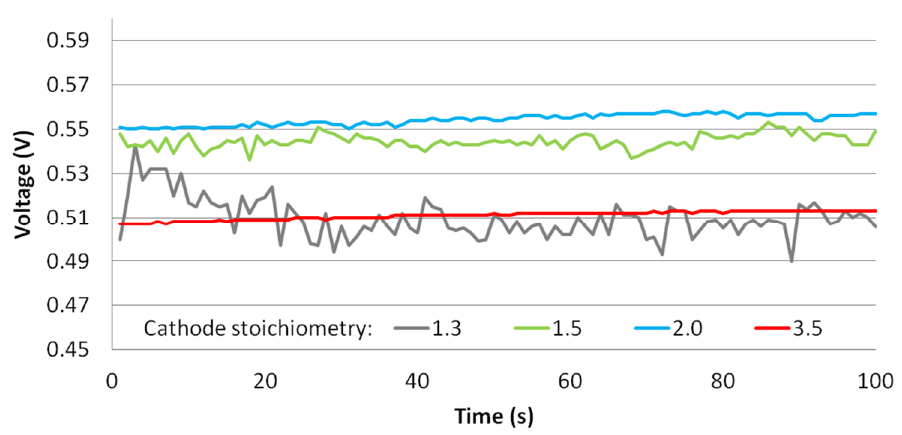
Figure 10. Time evolution of the cell voltage for the cathode stoichiometry tests at 1.0 A/cm 2 .